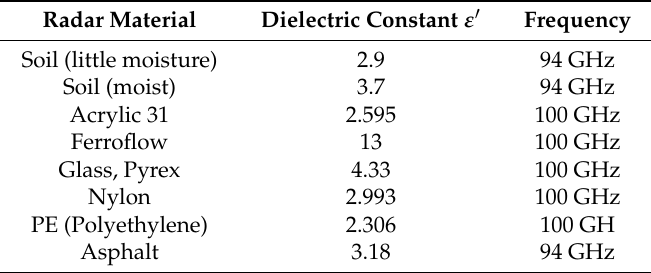
Table 1. W-band dielectric coefficients of